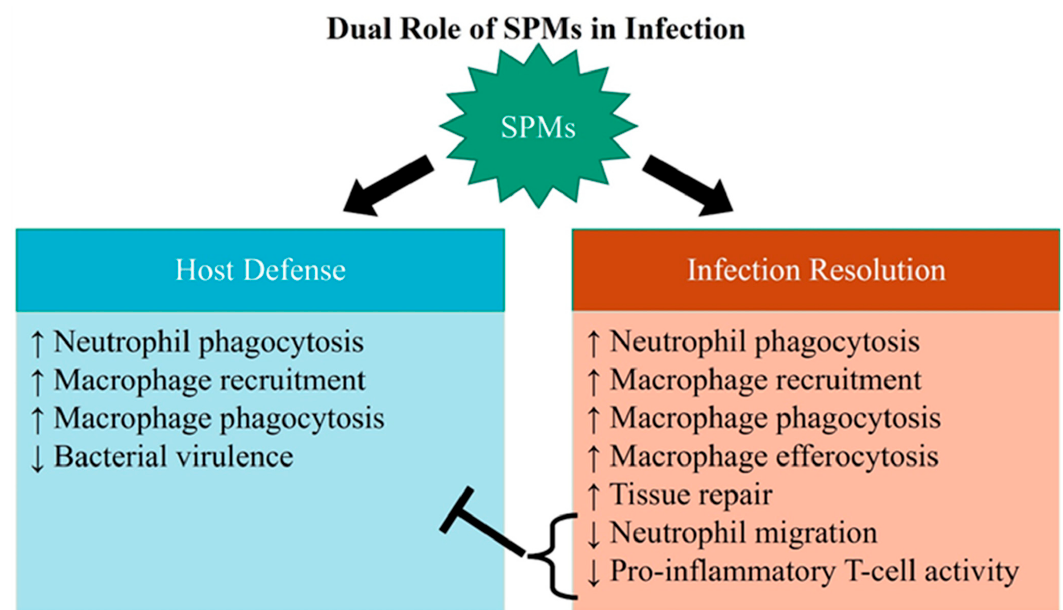
Figure 3. SPMs resolve inflammation as well as augment host defense. SPMs do however decrease neutrophil migration and decrease proinflammatory T-cell activity, which may attenuate host defense.